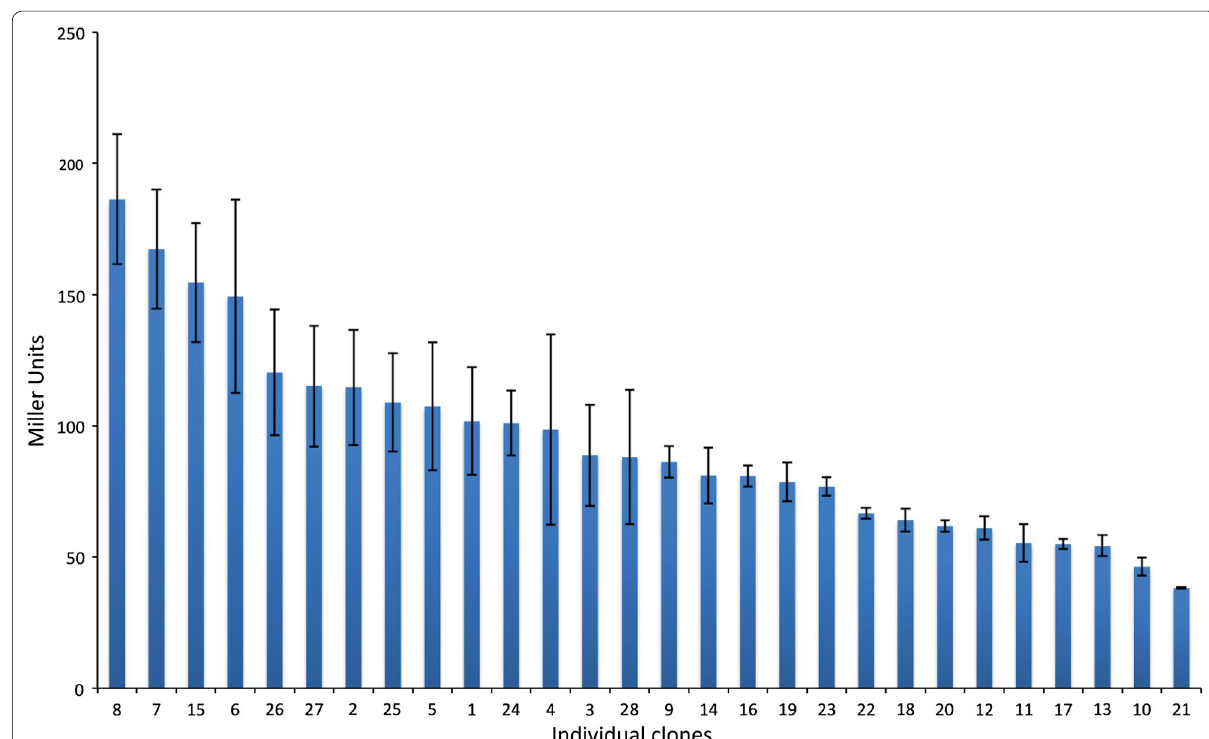
Fig. 2 Promoter activities as measured by the expression levels of thermostable β-galactosidase in E. coli . The activity measurement was based upon 35 min of incubation at 60 °C. Error bars indicate standard deviation calculated from triplicate